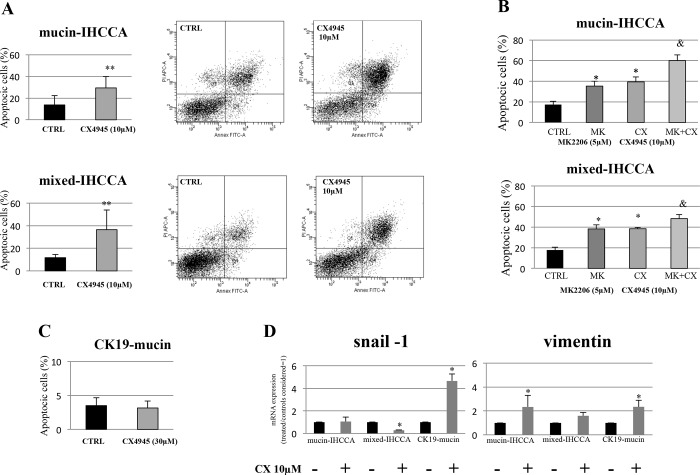
Apoptosis (Annexin V-FITC/PI by FACS) of primary cell cultures exposed to TGF-ΒR1 inhibitor (LY2157299) and CK2 inhibitor (CX4945), and RT-PCR analysis of snail-1 and vimentin in primary cell cultures exposed to CX4945.A:After 72 hrs of treatment, CX4945 10 μM induced apoptosis in both mucin- and mixed-IHCCA primary cell cultures ** = p<0.01 vs control. B:When CX4945 was combined with MK2206, an enhanced number of apoptotic cells was seen with respect to CX4945 or MK2206 alone. * = p<0.05 vs control and MK+CX; & = p<0.05 vs MK and CX alone. C: CX4945 30 μM did not induce apoptosis in CK19 mucin primary cells. D: CX4945 (10μM) treatment for 72h induced vimentin expression in all three primary cell cultures, whereas snail-1 expression was induced only in CK19-mucin, being down-regulated in mixed-IHCCA and unaffected in mucin-IHCCA. mRNA expression was normalized to control cells exposed to CX4945 carrier and considered equal to 1. * = p<0.05 vs control. Mean +/- SD of N = 3–5 independent experiments.